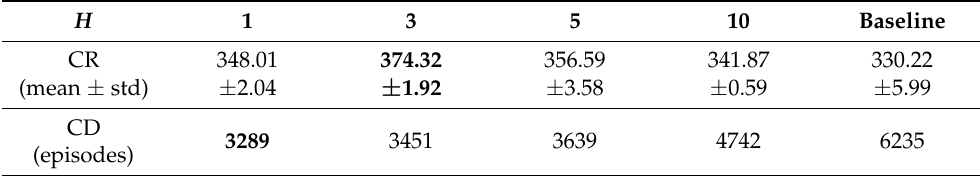
Table 5. Convergence performance for different trajectory